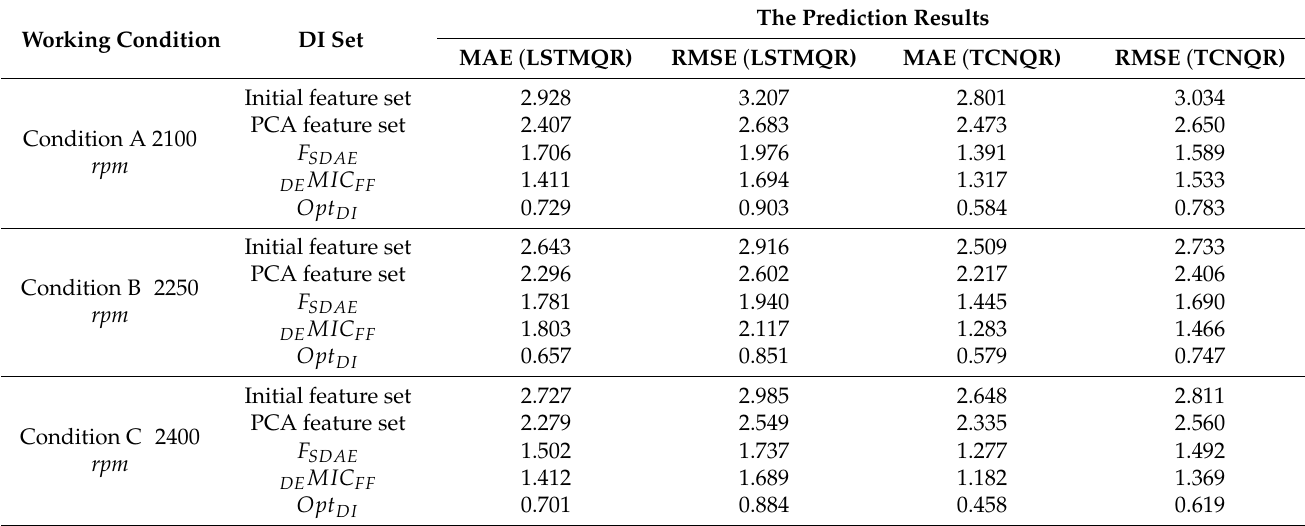
Table 3. Comparison of prediction accuracy at motor speeds of 2100 rpm , 2250 rpm and 2400 rpm using different DI set.